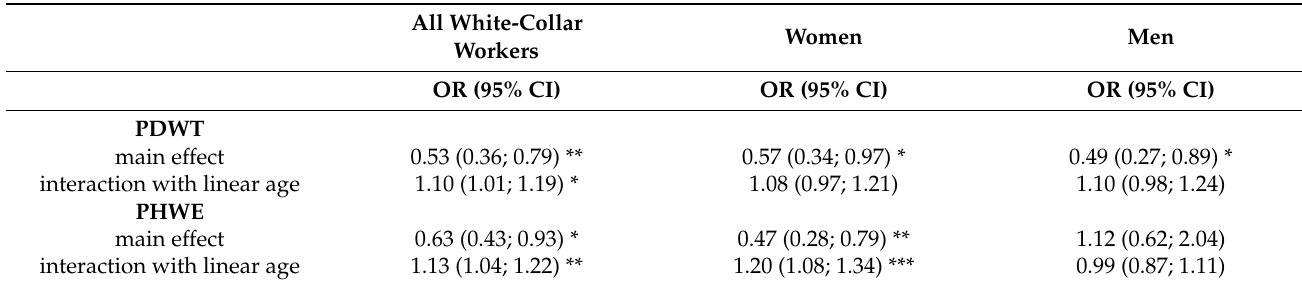
Fully adjusted for age (linear and quadratic), wave (categorical), education, marital status, parental status, working time, and caring for a relative (Model 4). *** for p < 0.001; ** for p < 0.01; * for p <